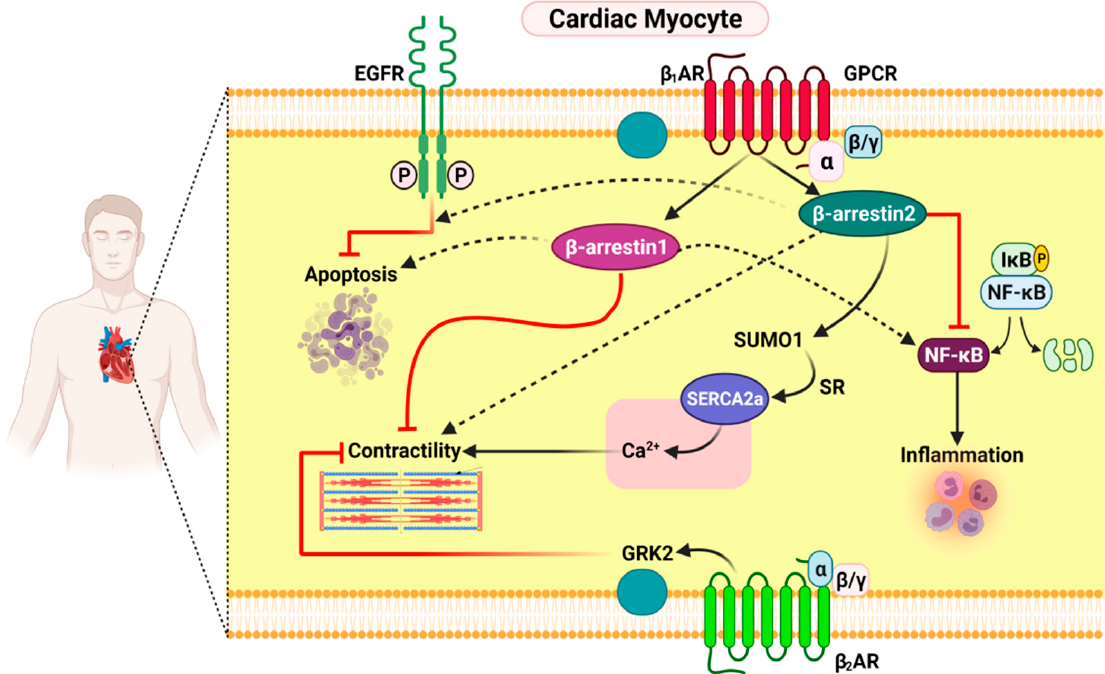
Figure 1. The functional distinction between β -arrestin1 and β -arrestin2 in cardiac myocytes. SR: sarcoplasmic reticulum; SUMO1: small ubiquitin-like modifier protein-1; EGFR: epidermal growth factor receptor; and AR: adrenergic receptor.